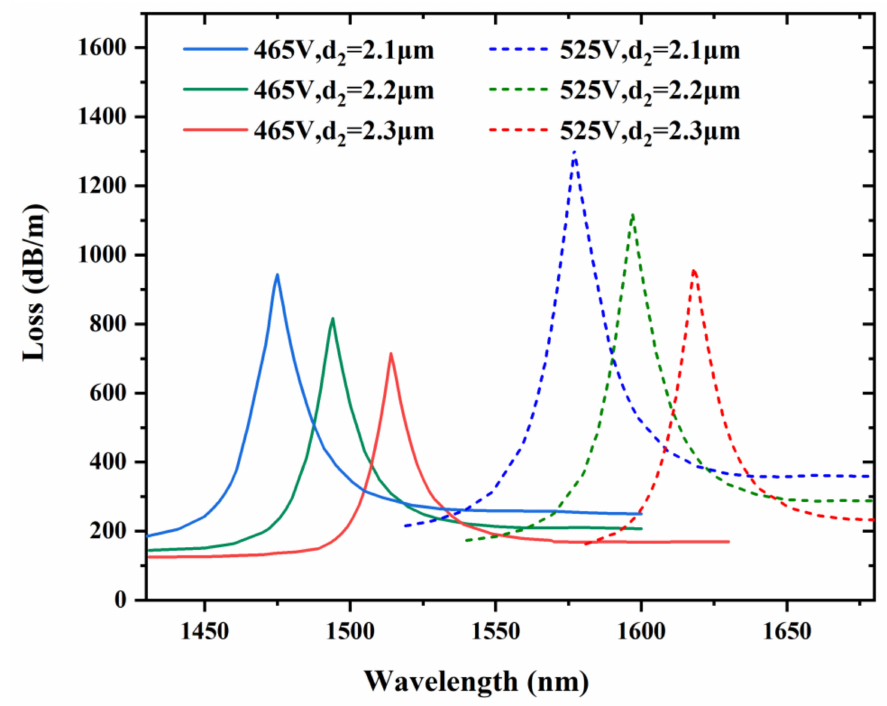
Figure 8. Variation in the confinement loss at the voltages of 465 and 525 V by varying the diameters of the two bigger air holes in the x-direction and d 2 = 2.1, 2.2, and 2.3 µ m, while other structural parameters are d = 1.4 µ m, d 1 = 1.4 µ m, and Λ = 3 µ